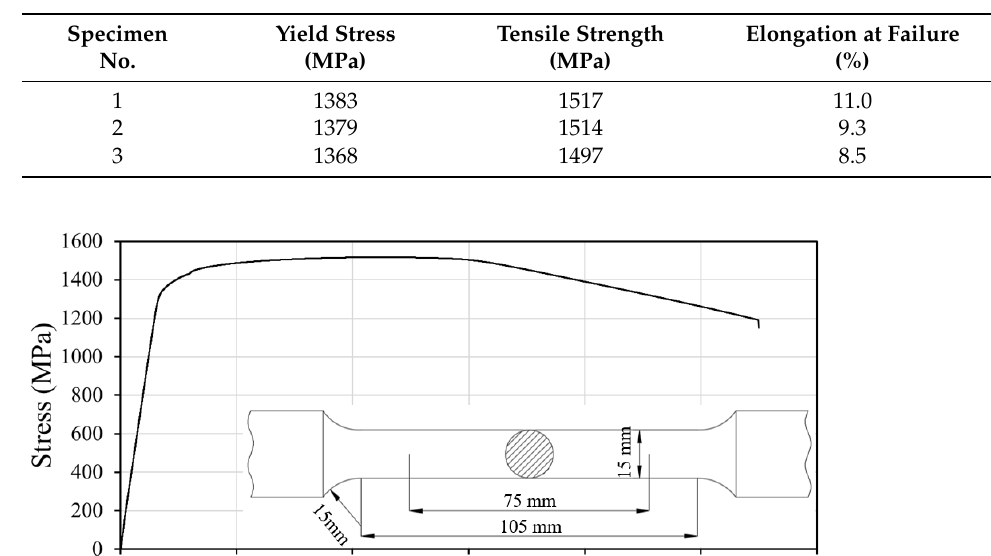
Figure 4. Assembly test setup.